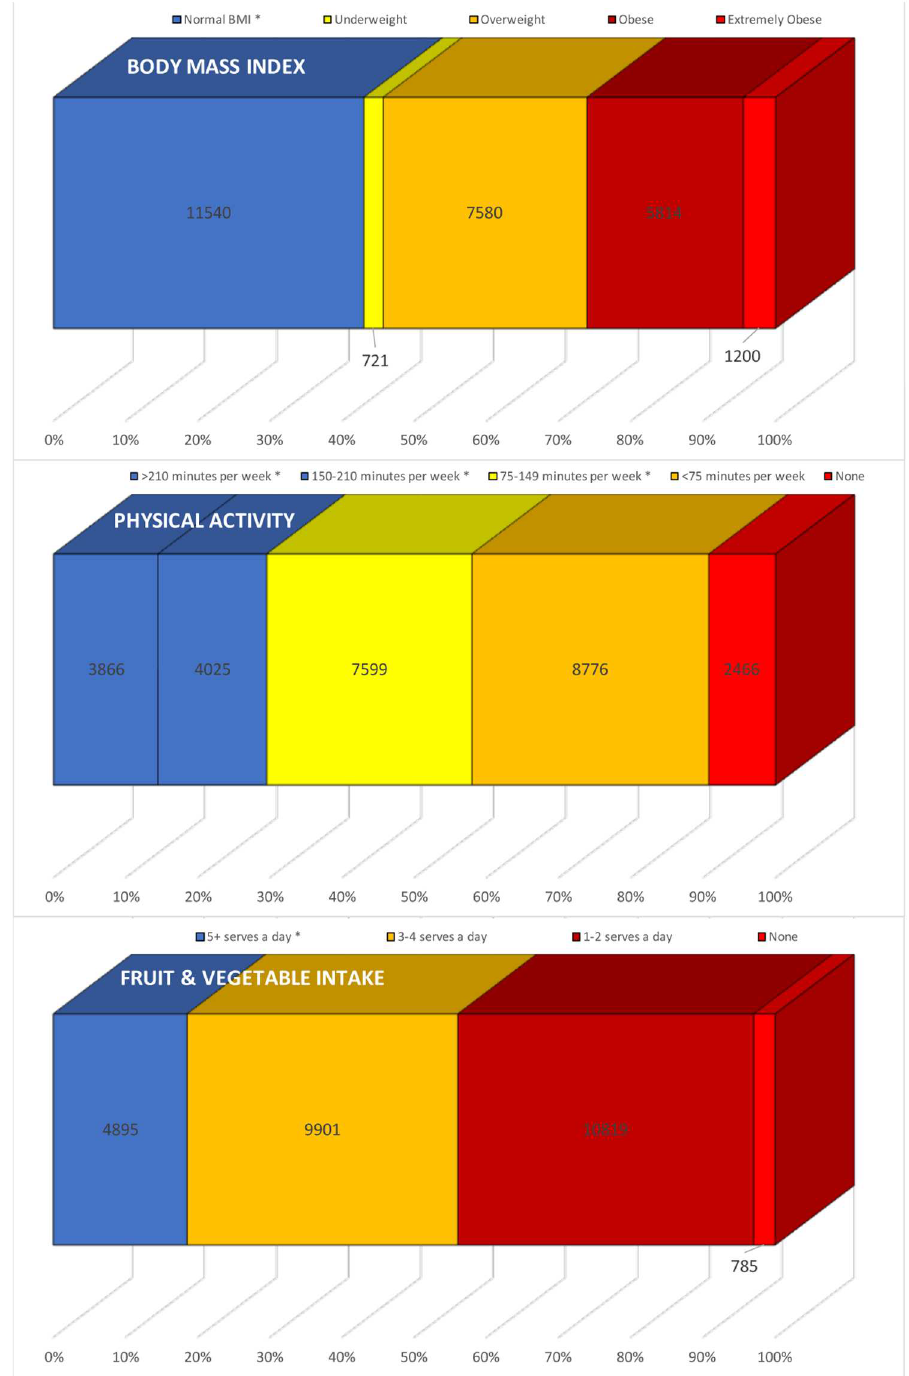
Fig 2. Distribution of lifestyle behaviours in women shown by published category of risk for disease.